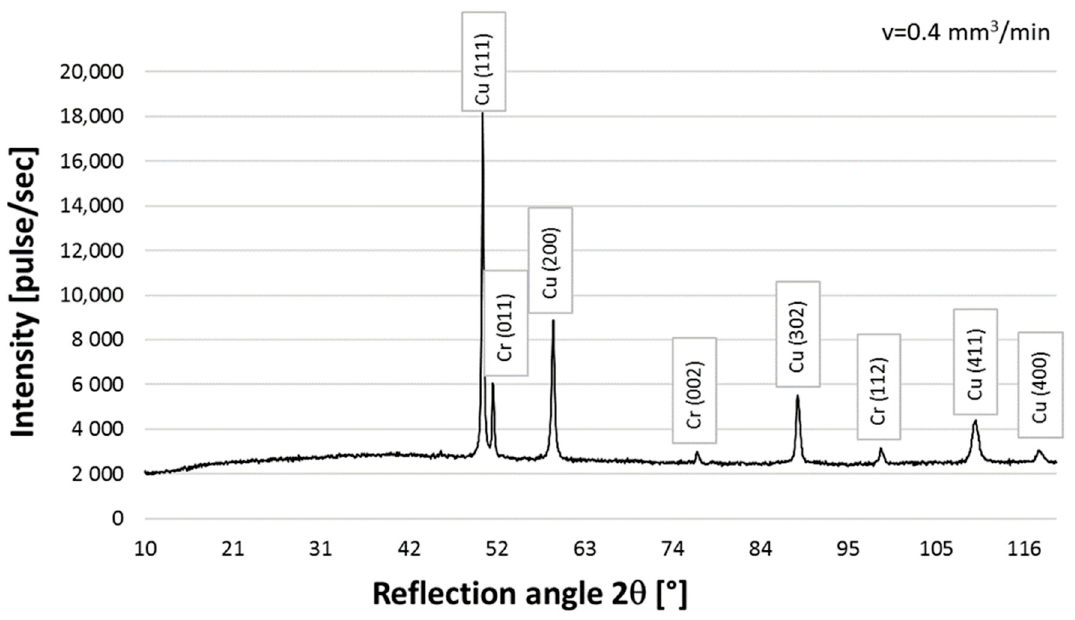
Figure 10. X-ray di ff raction pa tt ern for the qualitative CrAl coating on Cu-ETP copper, powder feed rate v = 0.8 mm 3 / min.